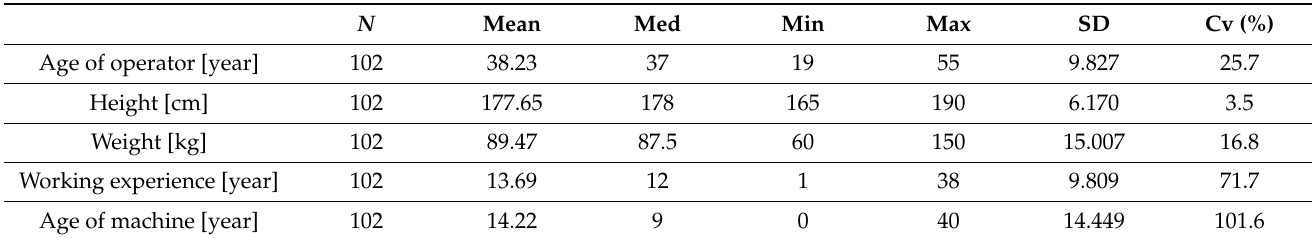
Table 1. Descriptive statistics for heavy mobile machinery operators—general